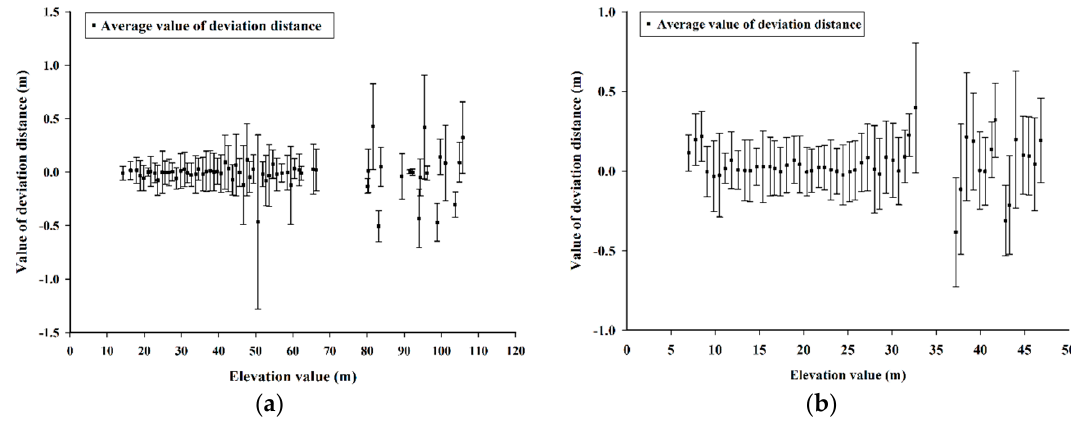
Figure 11. Evaluation of the building roofs’ deviations under different elevations, where the solid squares in the figures represent the average values of the deviation distances under each elevation range, and the error bars represent the positive and negative deviations of each average value: ( a ), ( b ) Region 1 and Region 2, respectively.